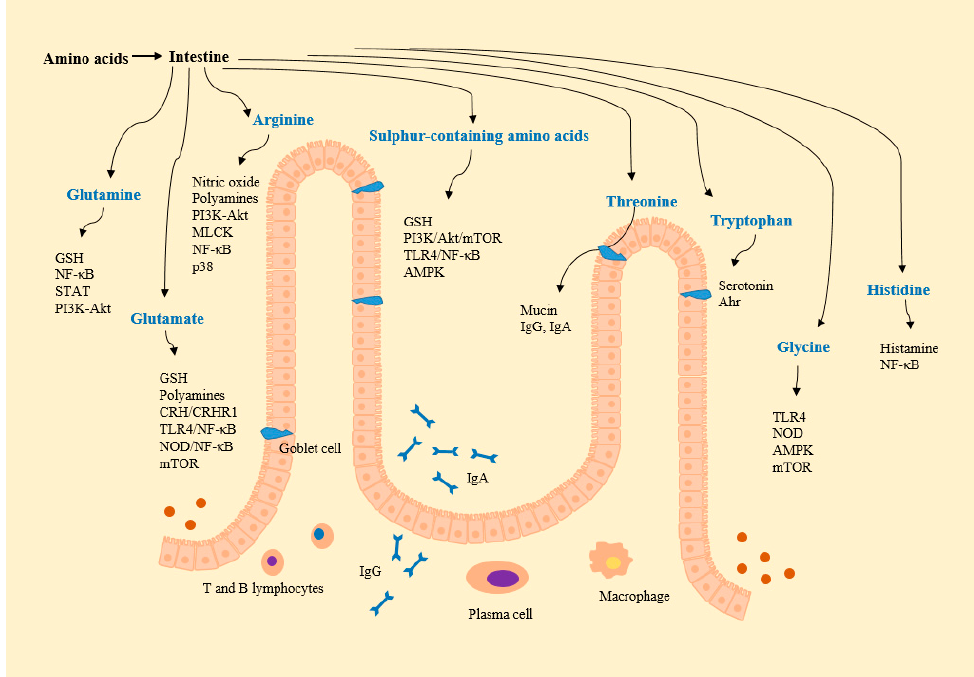
Figure 2. Amino acid-derived metabolites and amino acid-regulated signals. Ahr, aryl hydrocarbon receptor; Akt, protein kinase B; AMPK, AMP-activated protein kinase; CRH, corticotropin-releasing hormone; CRHR, CRH receptor; GSH, glutathione; MLCK, myosin light chain kinase; mTOR, mammalian target of rapamycin; NF- κ B, nuclear factor- κ B; NOD, nucleotide-binding oligomerization domain protein; PI3K, phosphoinositide-3-kinases; STAT, signal transducers and activators of transcription; TLR, toll like receptor.